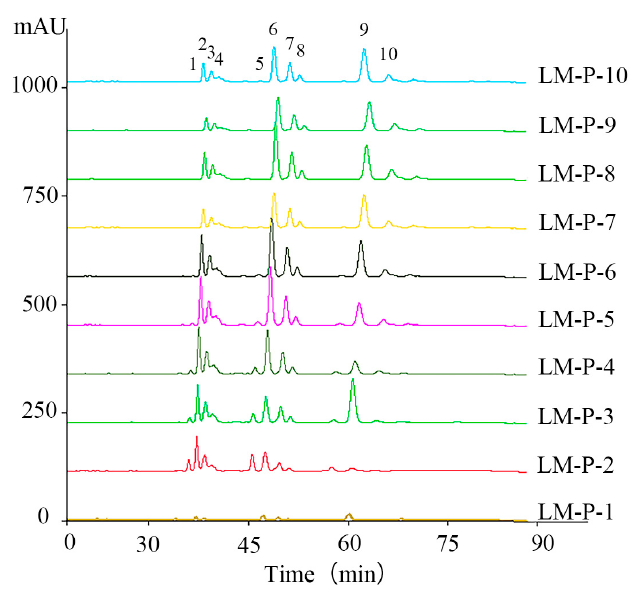
Figure 2. The HPLC fingerprints of ten fractions .